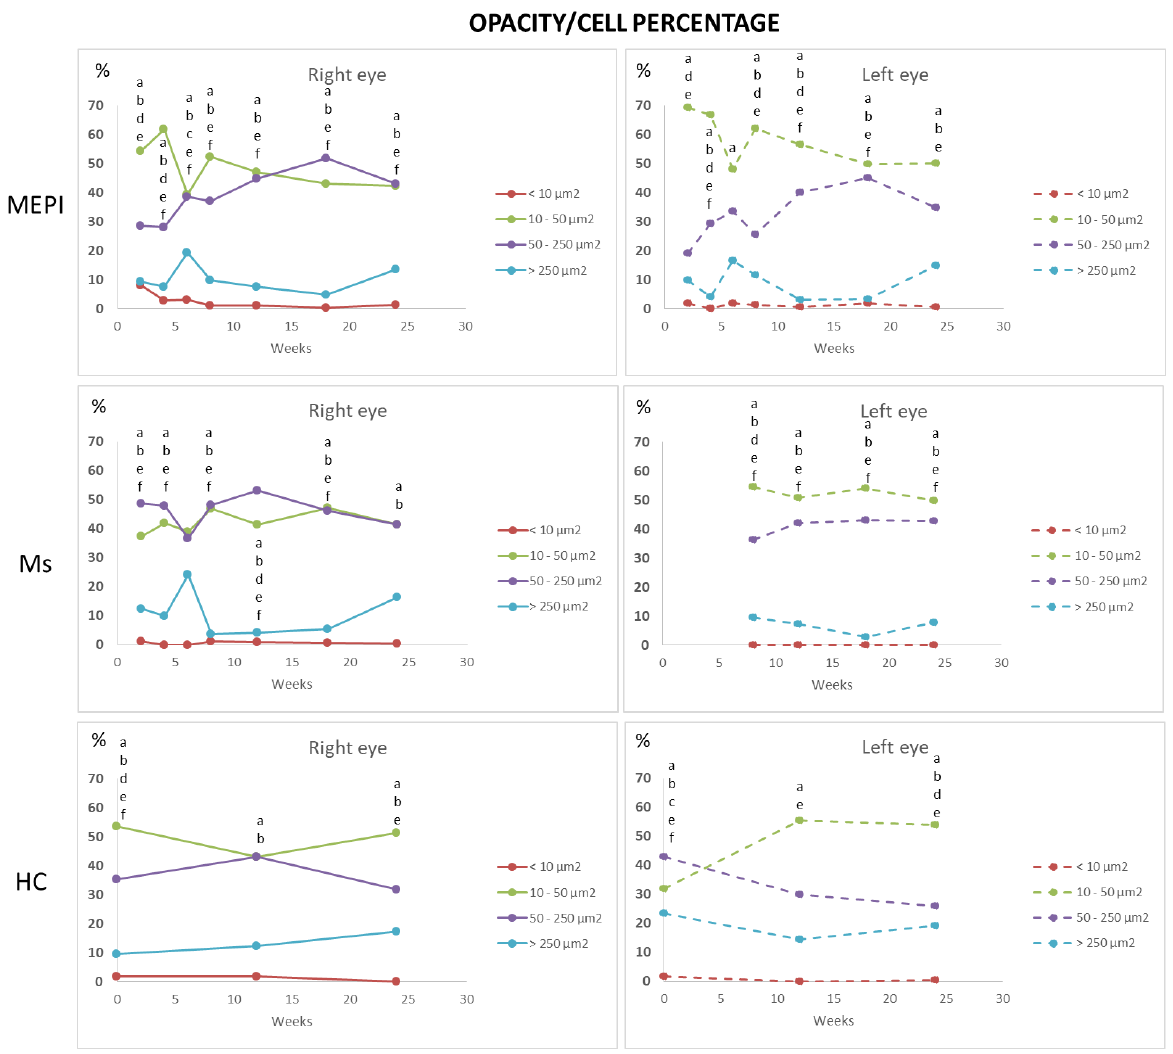
Figure 9. Changes in the vitreous immune population (opacities) in both chronic glaucoma models and healthy controls over 6 months. Abbreviations: MEPI: model induced by sclerosing the episcleral veins; Ms: model induced by injecting microspheres into the anterior chamber; isolated cells: opacities < 10 microns 2 (group 1); non-activated cells: 10–50 microns 2 (group 2); activated cells: 50–250 microns 2 (group 3); cell complexes: > 250 microns 2 (group 4). Data represented in percentages. Statistically significant differences ( p < 0.05) were highlighted with alphabetic markers as follows: a (group 1-group 2); b (group 1-group 3); c (group 1-group 4); d (group 2-group 3); e (group 2-group 4); f (group 3-group 4).